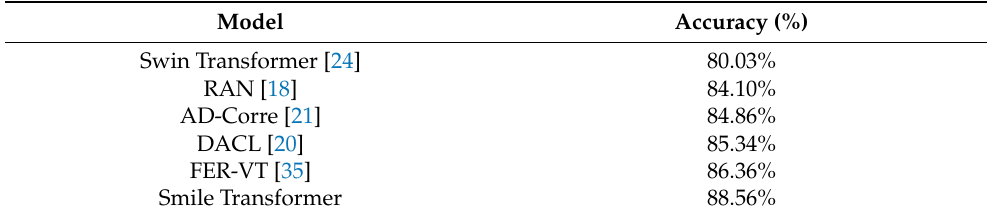
Table 3. Expression recognition performance (in terms of accuracy) of the various